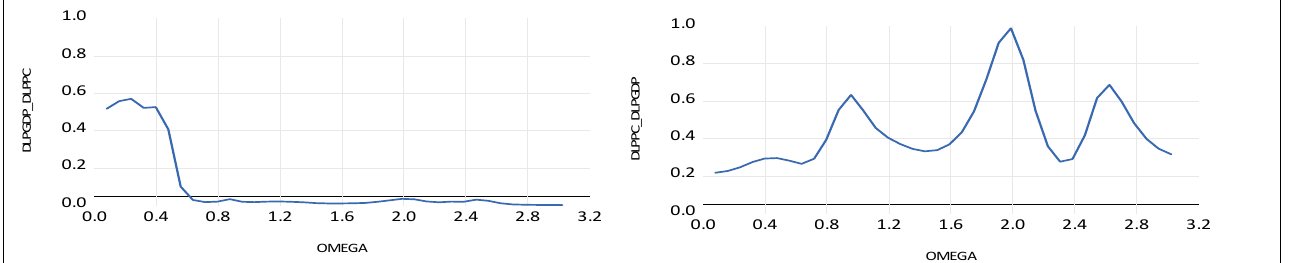
0.00.20.40.60.81.0